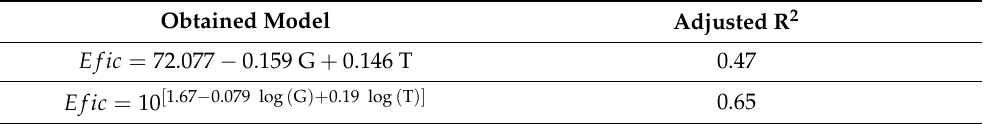
Table 12. Stepwise Multiple Linear Regression Models to Estimate Treatment Efficiency Using an HTF.